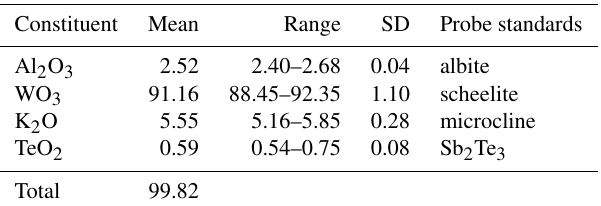
Table 1. Chemical data (in wt%) for